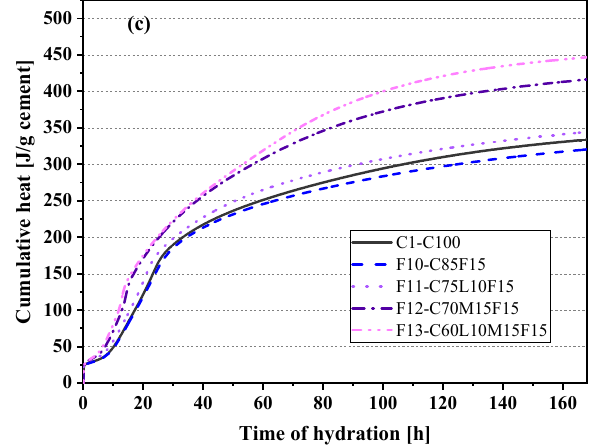
Figure 5. Cumulative hydration heat normalized to cement content: ( a ) the control specimen and LS system; ( b ) the control specimen and MK system; ( c ) the control specimen and FA